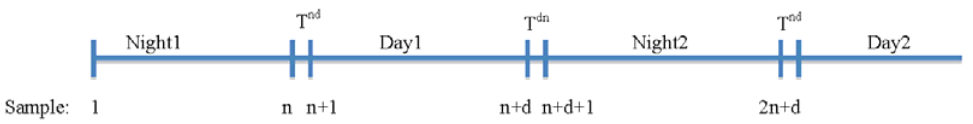
Figure 11. Sequence of night-day (T nd ) and day-night (T dn ) transitions.